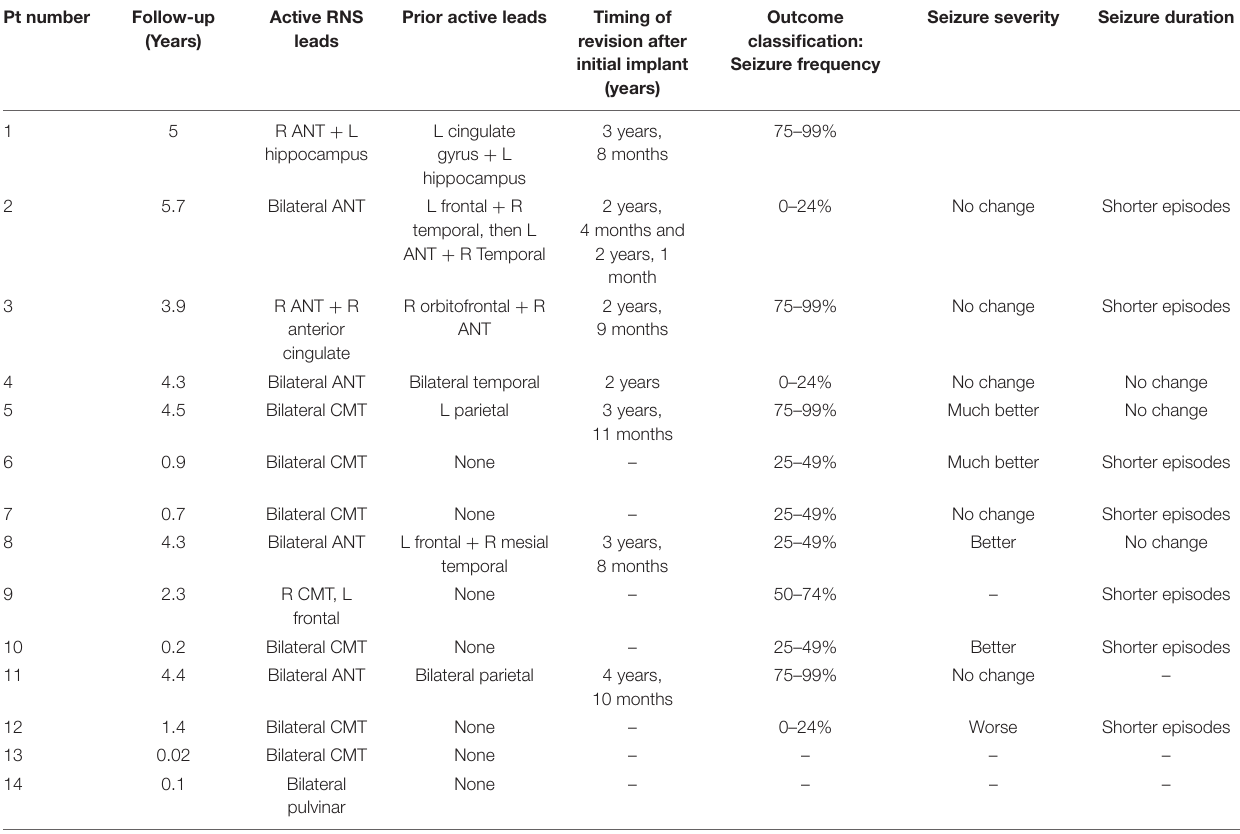
TABLE 4 | Patient